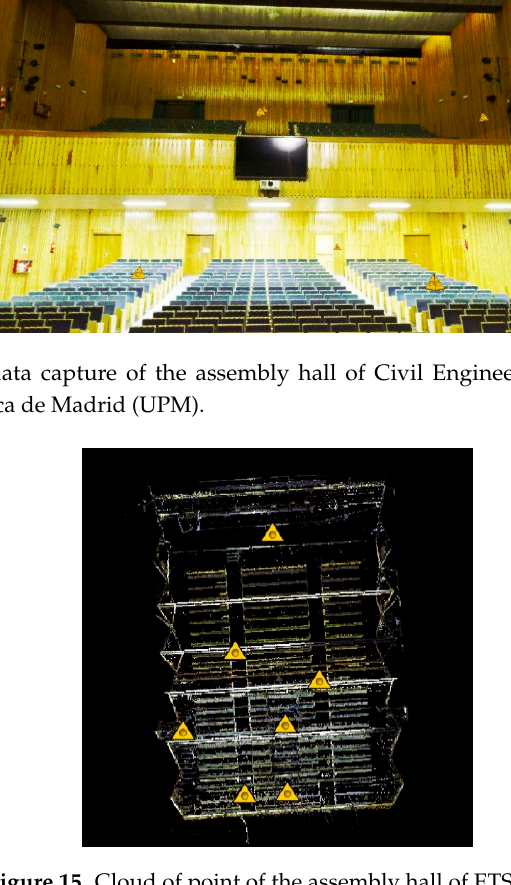
Figure 15. Cloud of point of the assembly hall of ETSICCP.